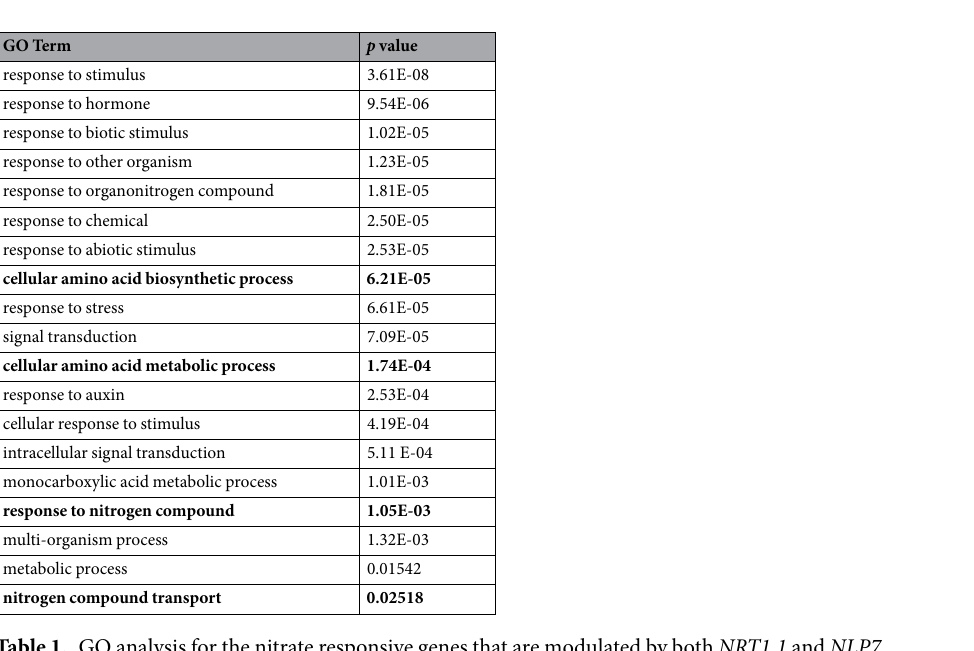
We also compared the gene expression between WT and the nlp7-4 mutant in response to nitrate. The results showed that there were 253 genes could respond to nitrate in both WT and the nlp7-4 mutant (Supplementary Fig. S4b, Supplementary Dataset 2). The expression of 337 genes (158 down-regulated and 179 up-regulated) was responsive to nitrate in WT, but not in the nlp7-4 mutant. 191 genes (102 down-regulated and 89 up-regulated) were responsive to nitrate exclusively in the nlp7-4 mutant, but not in WT. In total, 528 genes were differentially expressed in the nlp7-4 mutant. We compared the 528 differentially expressed genes in the nlp7-4 mutant and 485 differentially expressed genes in the chl1-13 mutant and found 342 genes (64.8% of 528 and 70.5% of 485) were regulated by both NLP7 and NRT1.1 (Fig. 4, Supplementary Dataset 3) while 143 and 186 genes were regulated only by NRT1.1 and NLP7 , respectively (Fig. 4, Supplementary Dataset 4). Gene Ontology (GO) analysis of 342 shared genes showed four clusters related to nitrogen, including cellular amino acid biosynthetic process, cellular amino acid metabolic pro- cess, response to nitrogen compound, and nitrogen compound transport (Table 1). In these four clusters, genes involved in amino acid synthesis and nitrate transport were enriched (Supplementary Dataset 5). These data indicate extensive overlap in the target genes modulated by NLP7 and NRT1.1 and provide additional support that both NLP7 and NRT1.1 work in the same pathway in nitrate signaling. The 186 and 143 genes exclusively regulated by NLP7 and NRT1.1 , respectively (Supplementary Dataset 4) were further investigated by GO analysis. Among the 186 genes regulated by NLP7 , there are two nitrogen-related clusters (response to nitrogen compound and nitrogen compound transport) (Table 2), including genes involved in amino acid transport and nitrate transport (Table 3). Among the 143 genes modulated by NRT1.1 , three nitrogen-related clusters were found (response to nitrogen compound, cellular response to nitrogen compound,